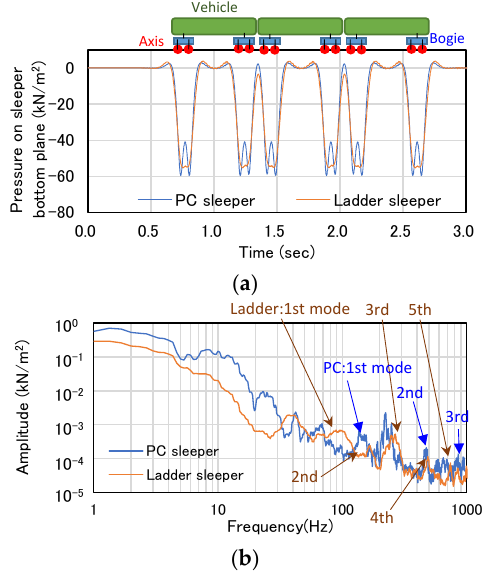
Figure 16. Analysis results of train running (CASE2): ( a ) time-history waveform of pressure on sleeper bottom plane of each sleeper; ( b ) frequency characteristics of pressure on sleeper bottom plane of each